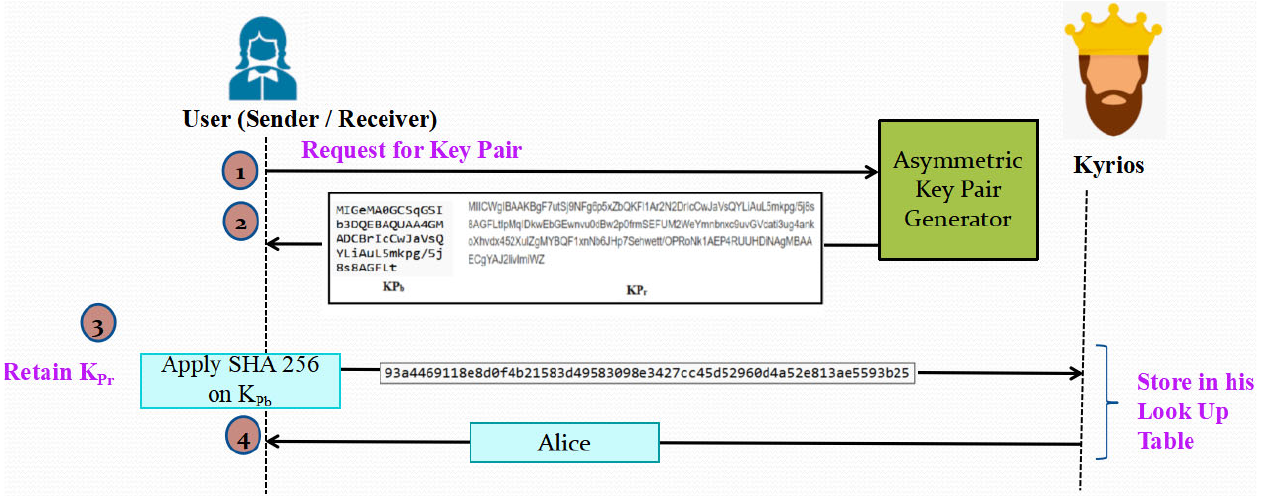
Figure 11. Demonstration of Phase 1: Registration Process.